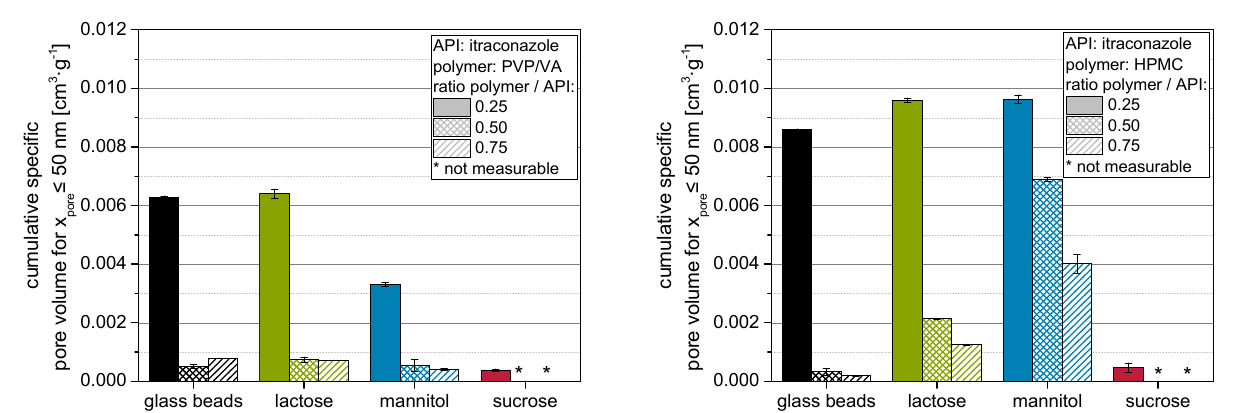
Figure 6. Results of BJH measurements of nanoparticle-loaded granules produced with itraconazole nanosuspensions containing different amounts of PVP/VA or HPMC as stabilizing polymers and glass beads, lactose, mannitol or sucrose as carrier material ( n = 2, * refers to a detected porosity of 0).